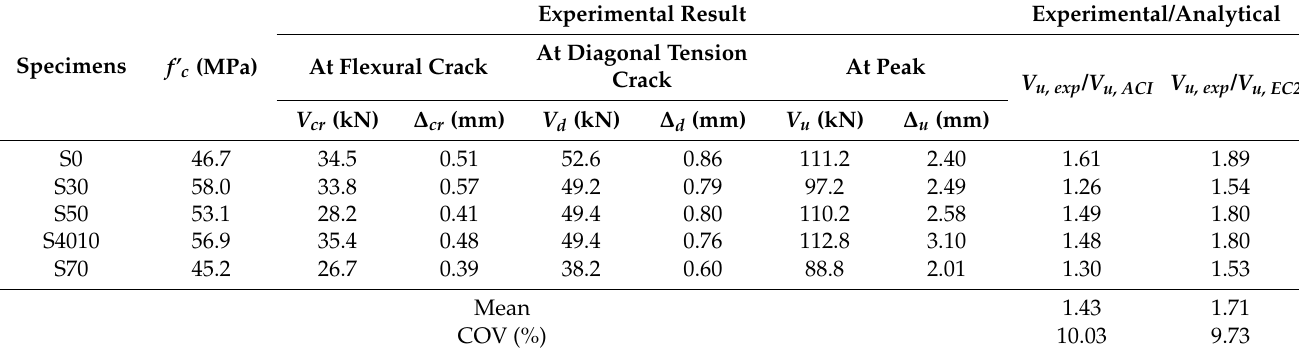
Table 4. Comparison between analytical and experimental results of S